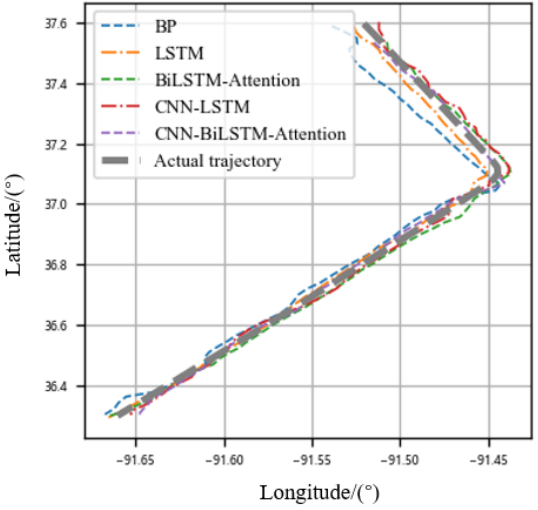
Figure 15. Comparison of prediction results of five models.